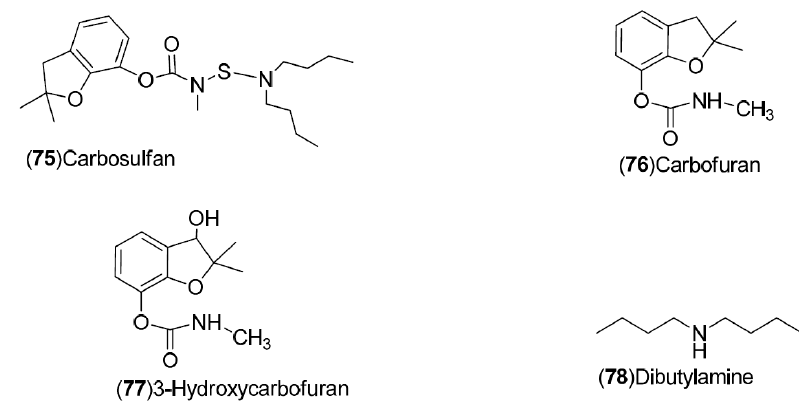
Figure 6. Chemical structures of carbohydrates.